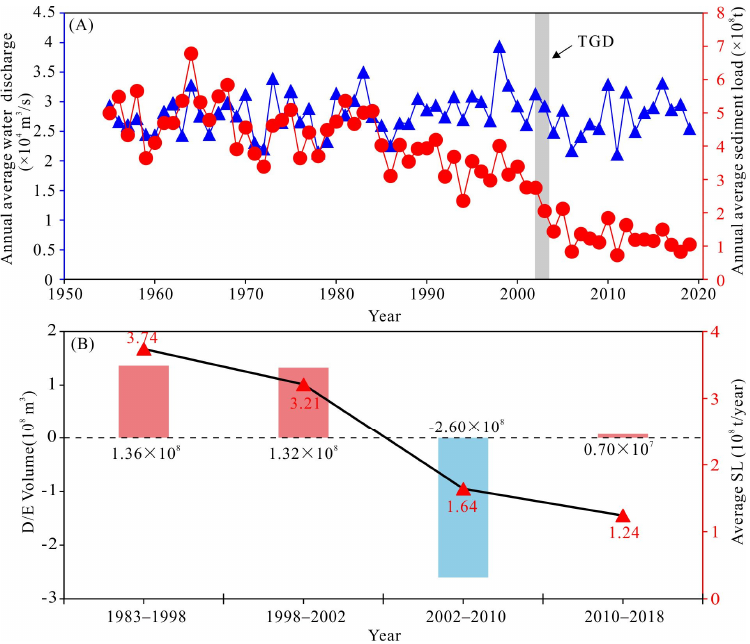
Figure 9. ( A ) Average annual discharge (left axis) and suspended sediment load (SSL) (right axis) at the Datong station from 1955 to 2018. ( B ) The correlation between the annual sediment load at Datong and the annual volume change in the SCSP. The long-term suspended sediment loads and river discharge were obtained from the Yangtze River Sediment Bulletin (published on http://www.cjh.com.cn, accessed on 1 January 2022). Note: TGD means the Three Gorges Dam.